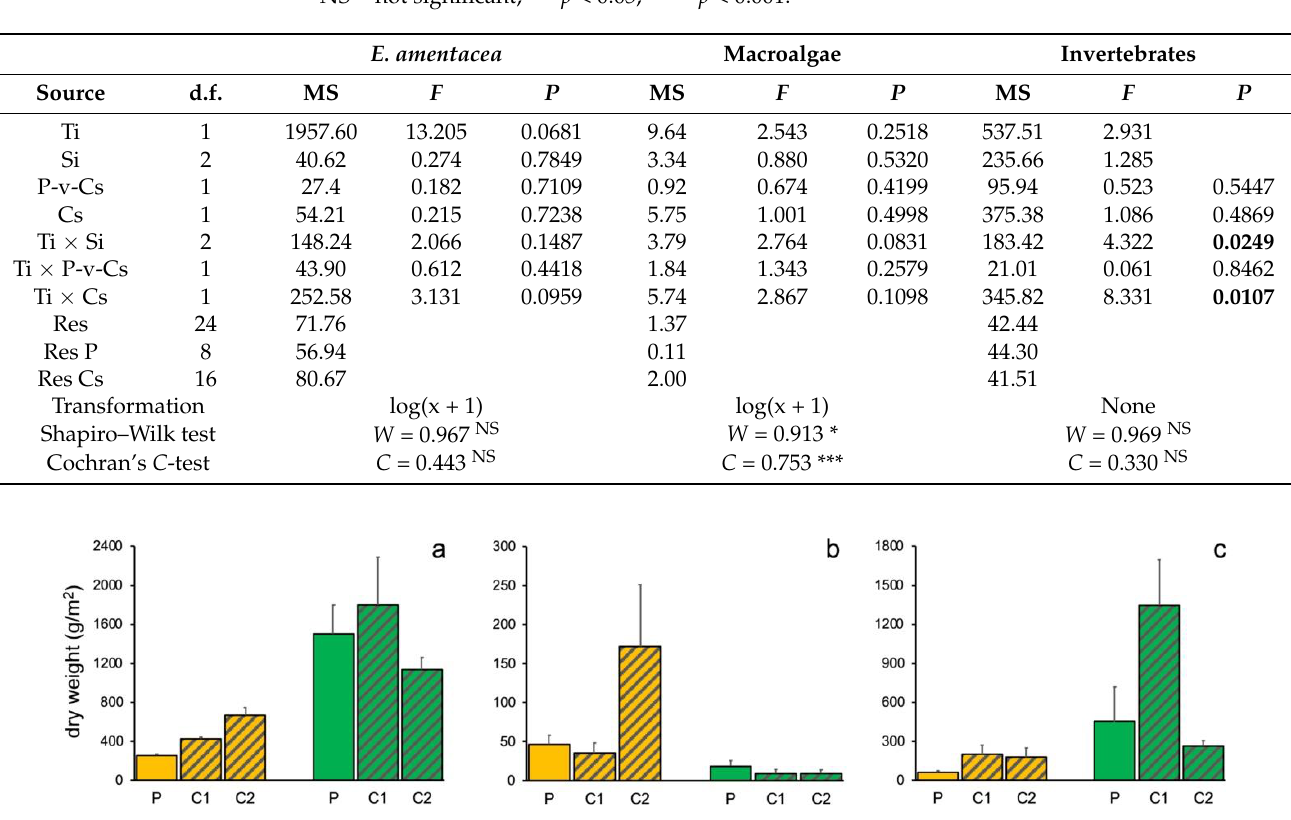
Table 1. Summary of asymmetrical ANOVA testing for differences between P and Cs in total biomass (dry weight) of E. amentacea , associated macroalgae, and invertebrates at PFN. The main effect of